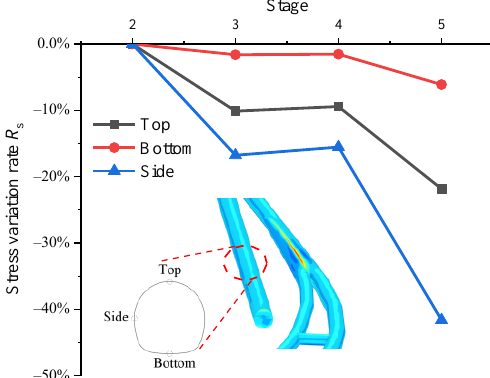
Figure 15. Non-intersection tunnel stress reduction.